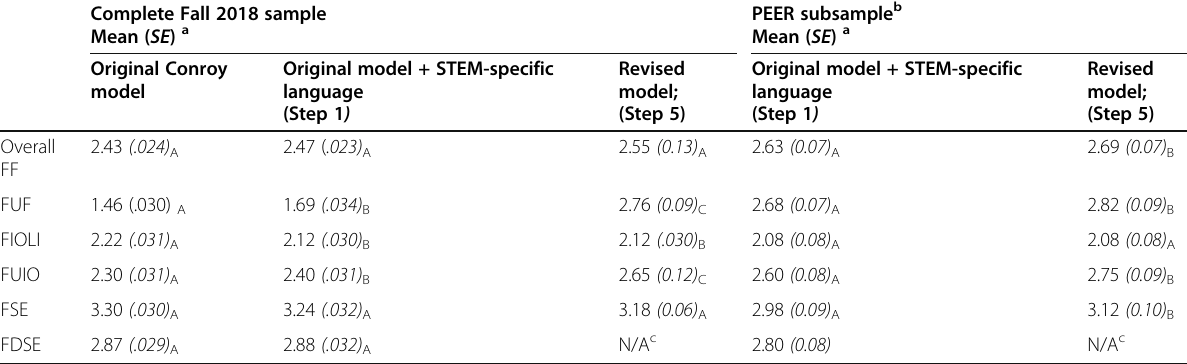
Table 8 Mean and standard error of PFAI dimensions by model type Complete Fall 2018 sample Mean ( SE )